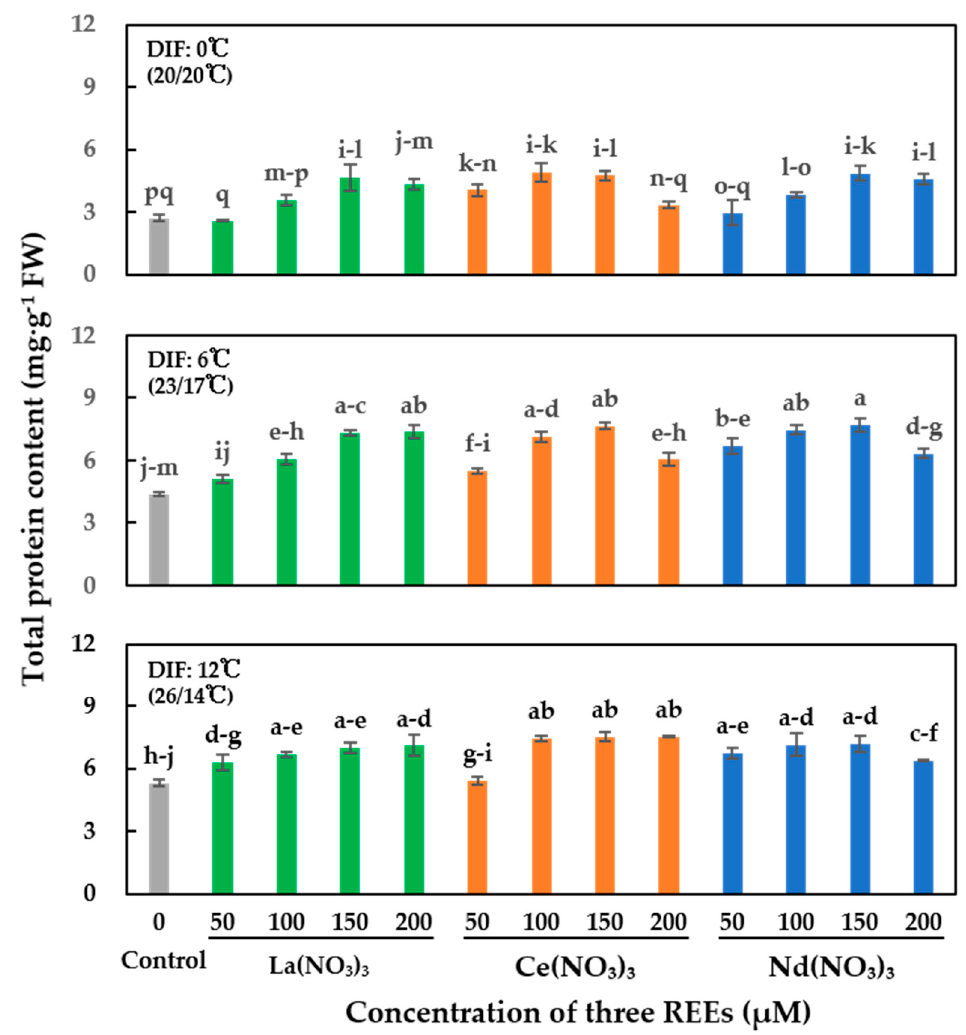
Figure 2. Effects of DIF and REE supplementation on total protein content in D. aphyllum. The error bars represent the SEs of biological replicates (n = 3). Different letters within each panel indicate statistically significant differences at p = 0.05 using Duncan’s multiple range